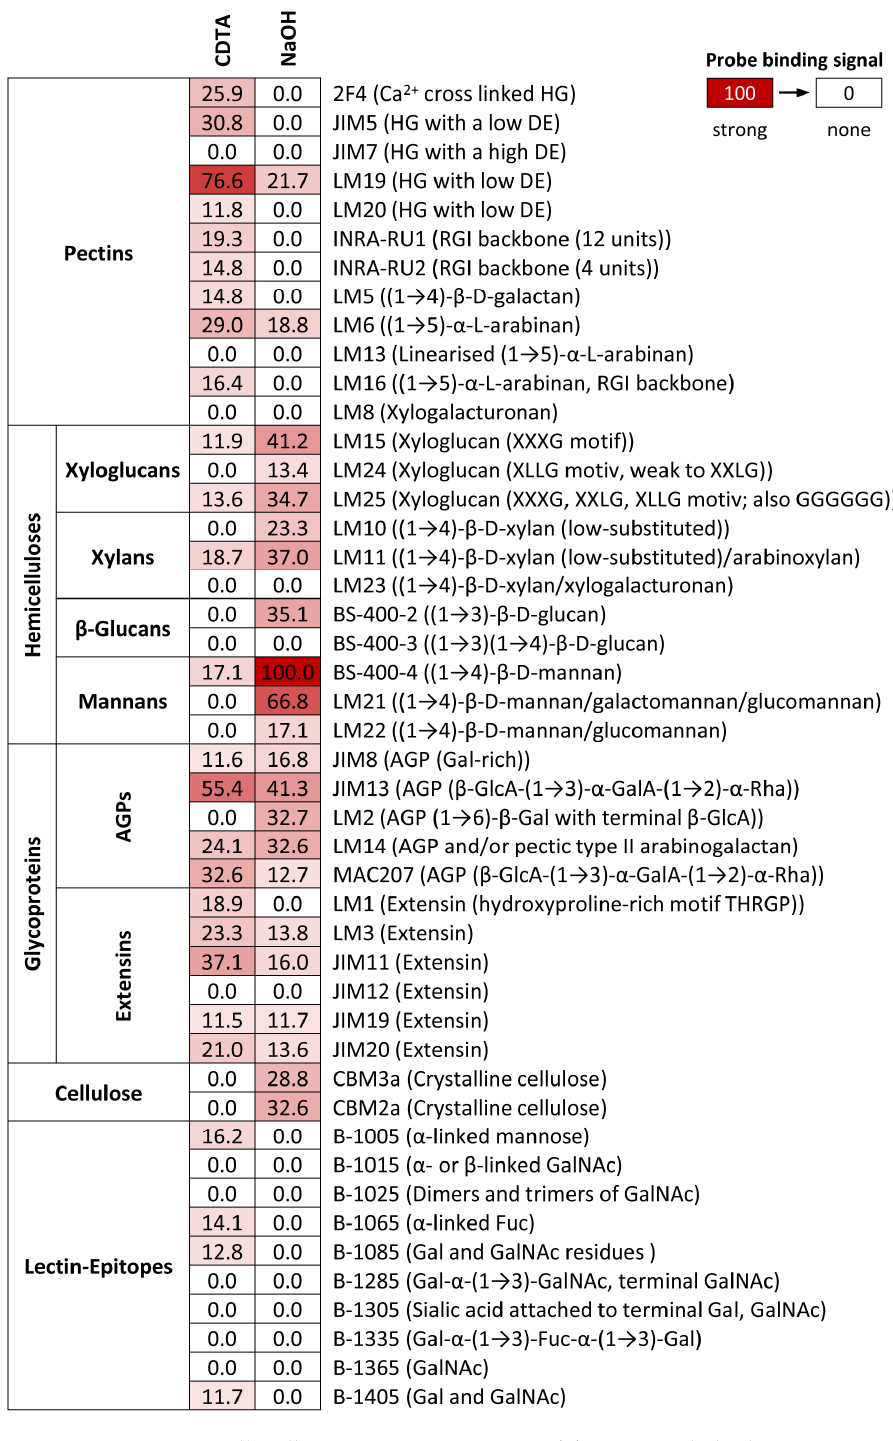
Figure 5. Determining cell wall epitopes in Spirogyra mirabilis using carbohydrate microarray profiling. A total of >40 cell wall probes were incubated with CDTA and NaOH extracts sequentially prepared from Spirogyra AIR. The heatmap color intensity shows the strength of the probe binding. The strongest signal was assigned a value of 100 and the cut-off signal was set to 5. Probe codes are in bold